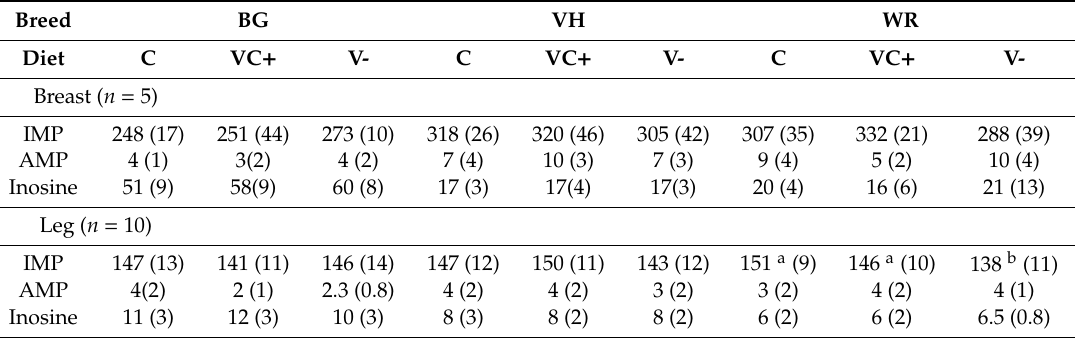
Table 3. Means (standard deviations) for IMP, AMP, and inosine content of breast ( n = 5) and leg ( n = 10) muscles per breed (BG = Bresse Gauloise, VH = Vorwerkhuhn, WR = White Rock) and feed (C = control, VC + = high in vicin, VC- = low in